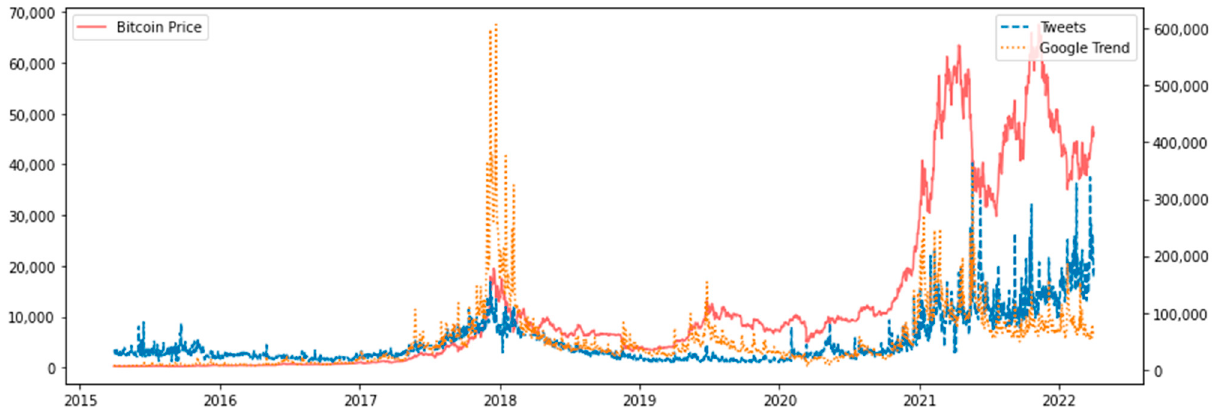
Figure 5. Google Trend, daily Tweets, and Bitcoin price chart.